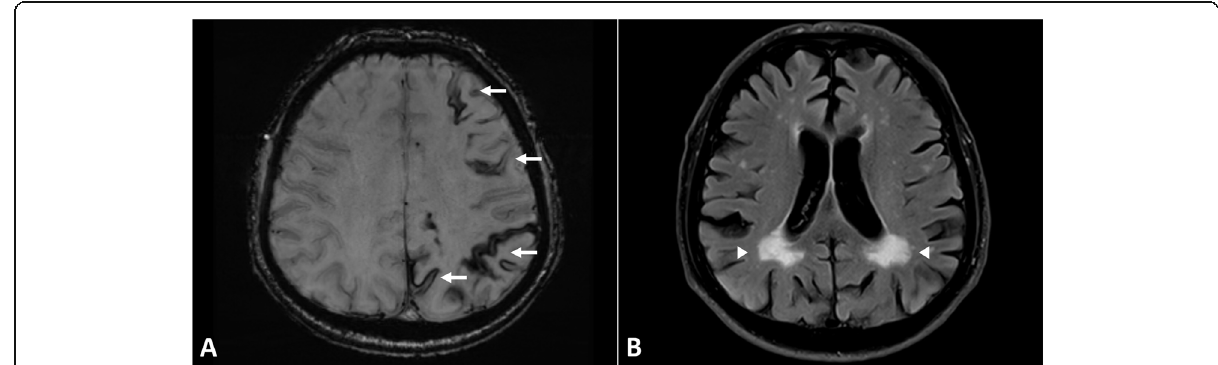
Fig. 2 Follow-up neuroimaging findings at 1 year. Legend: Axial brain MRI with susceptibility-weighted imaging sequence showing that cortical superficial siderosis has been slightly restricted compared to the baseline MRI (Panel a , arrows). Axial brain MRI with fluid-attenuated inversion recovery sequence showing stabilization without further expansion of the symmetrical periventricular white matter hyperintensities compared to the baseline MRI (Panel b ,